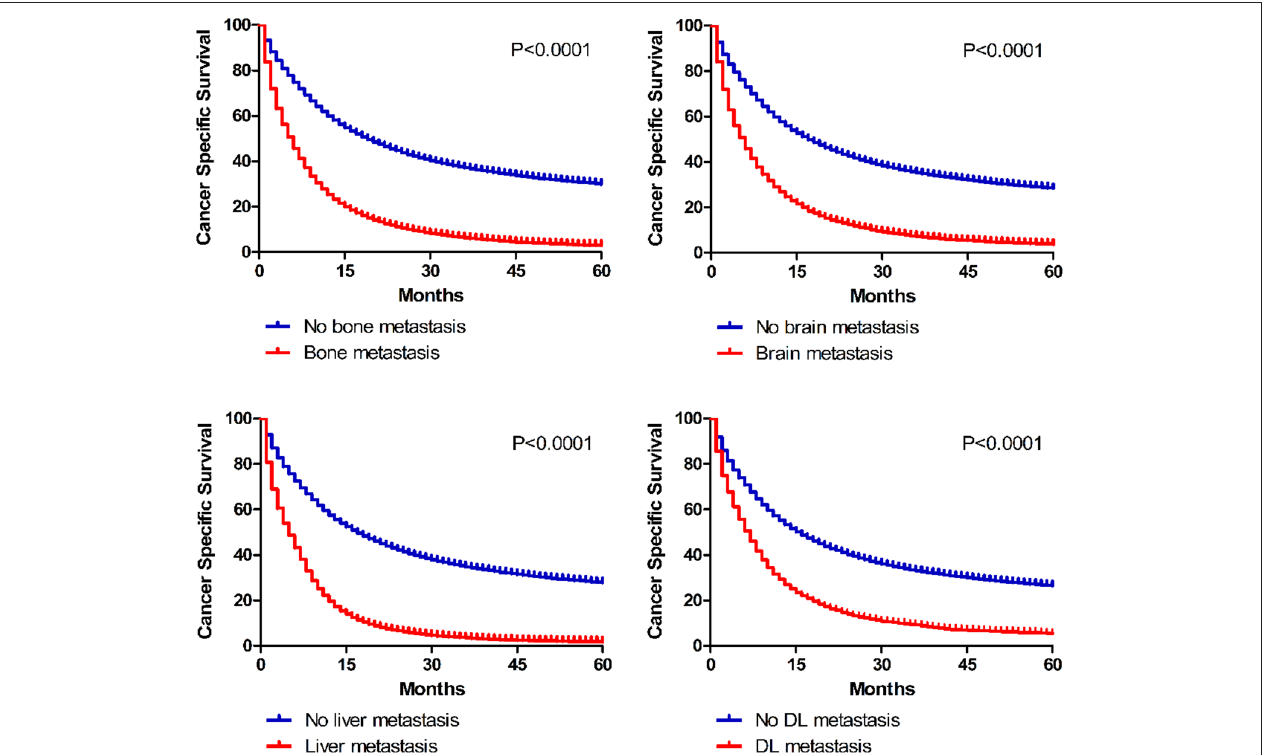
FIGURE 5 | Kaplan–Meier curves of cancer specific survival in patients according to metastatic status.